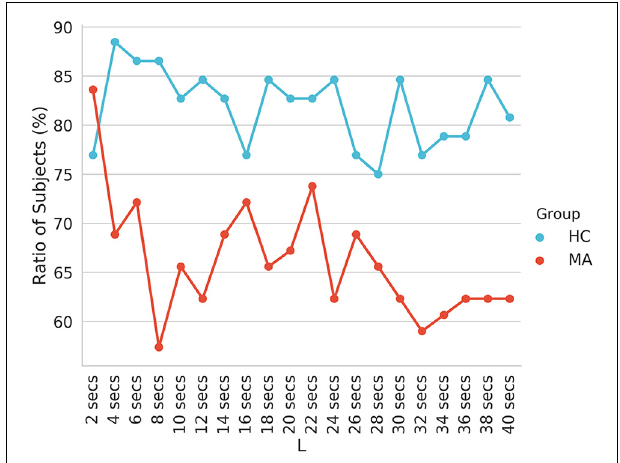
FIGURE 5 | The ratio of subjects with non-stationary transition matrices ( p < 0.05) of EEG-ms evaluated at different block lengths.